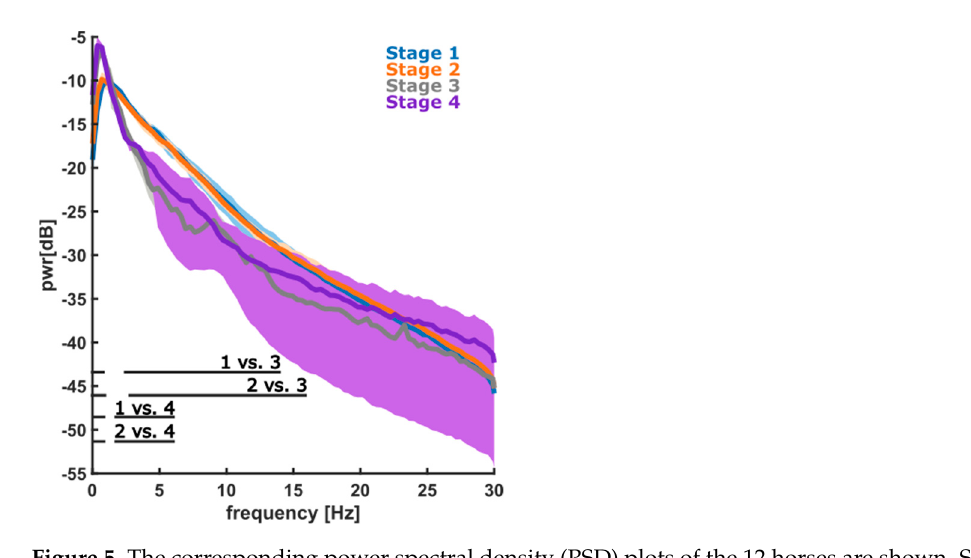
Figure 5. The corresponding power spectral density (PSD) plots of the 12 horses are shown. Stage 1—induction, stage 2—surgery, stage 3—early recovery, and stage 4—late recovery. The significant difference ( p < 0.05) between stages was noted in the graph.